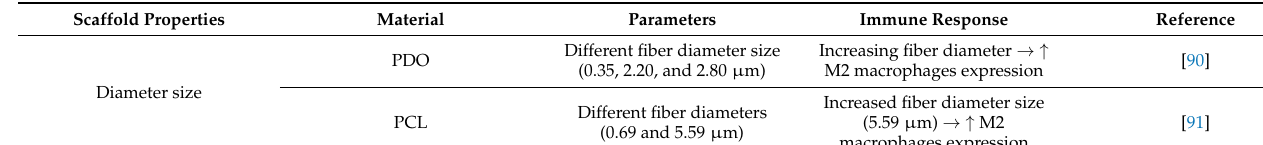
Table 1. Overview of the influence of different electrospun scaffolds properties on immune